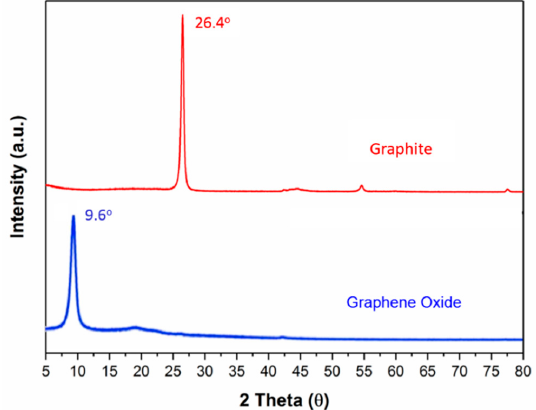
Figure 2. XRD spectra of graphite flakes and GO nanosheets.